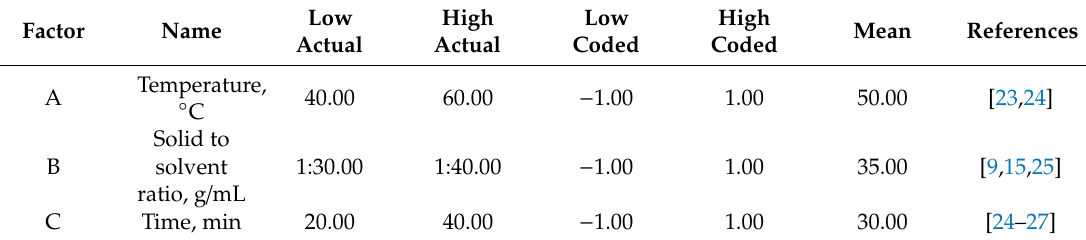
Table 1. The level use in central composite design (CCD).